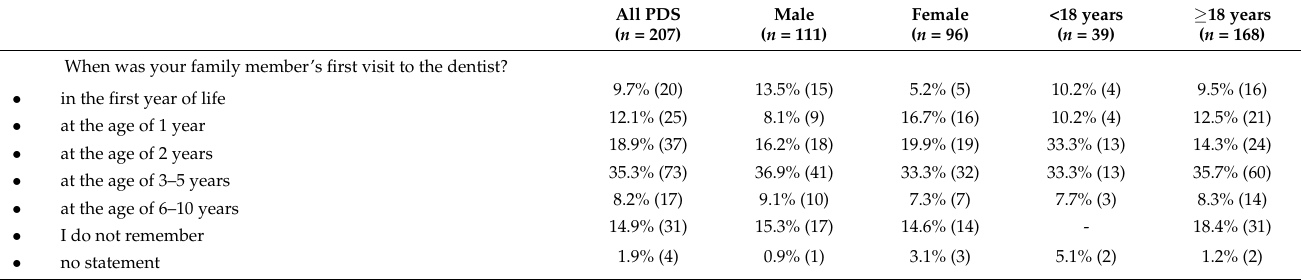
Table 4. Information about the professional dental care for the People with Down Syndrome (PDS), as reported by the person who completed the